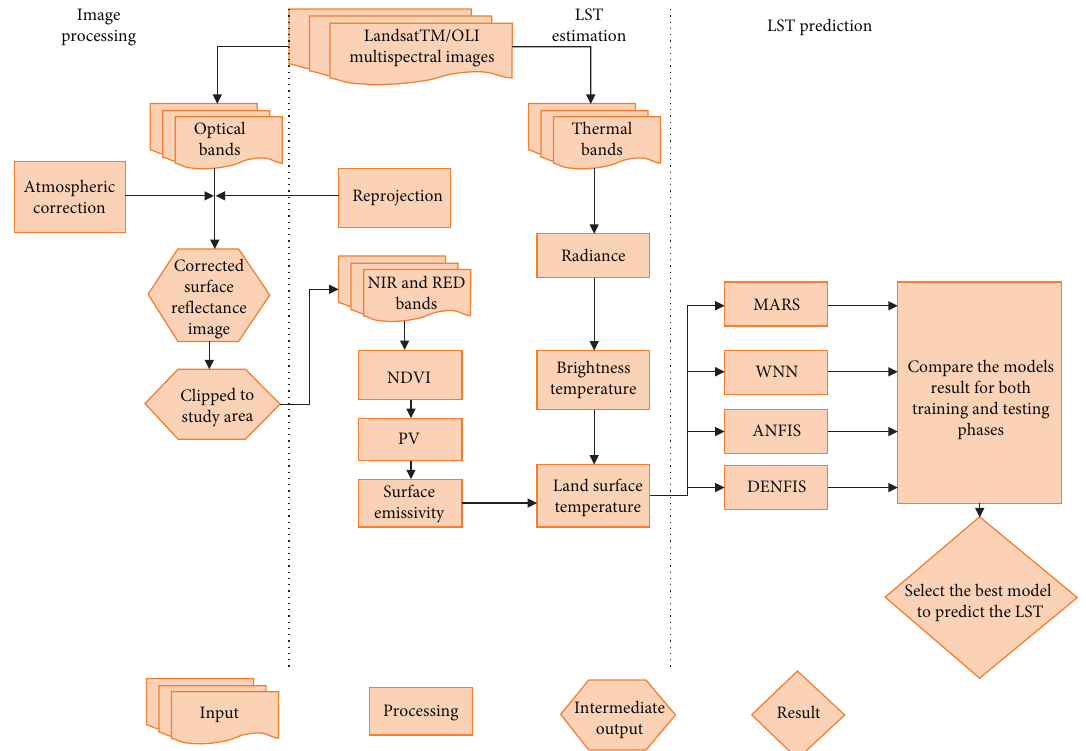
Figure 2: Flowchart of the downscaling algorithms used in this study.